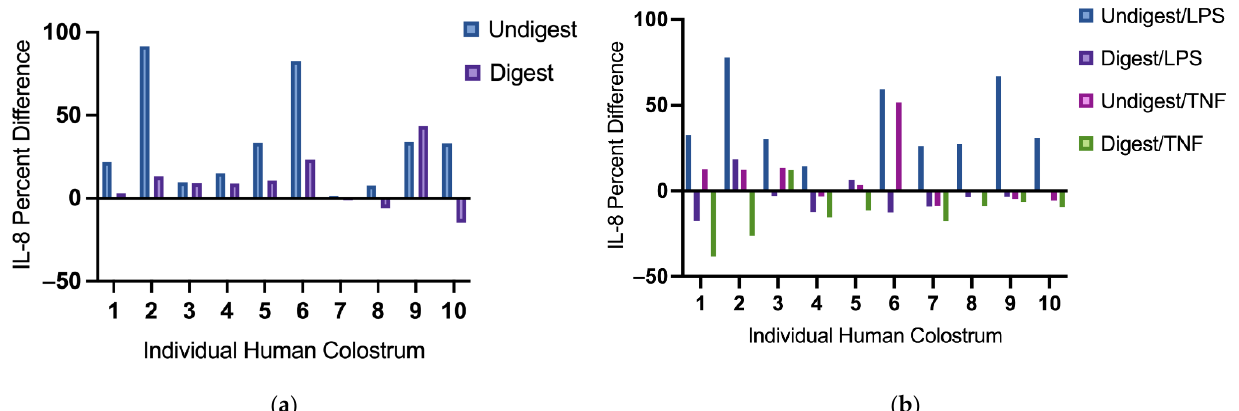
Figure 2. Interleukin-8 difference in individual digested and undigested human colostrum in response to no stimulus ( a ) and stimuli (lipopolysaccharides or tumor necrosis factor) ( b ). Percent difference was calculated to identify the change of IL-8 production in Caco2BBe cells pretreated with digested or undigested colostrum against their unpretreated counterparts. It was calculated as: (Pretreated IL-8 production − Unpretreated IL-8 production)/Unpretreated IL-8 production × 100. From left to right: human colostrum sample 1–10. IL-8 = interleukin-8; LPS = lipopolysaccharides; TNF = tumor necrosis factor.